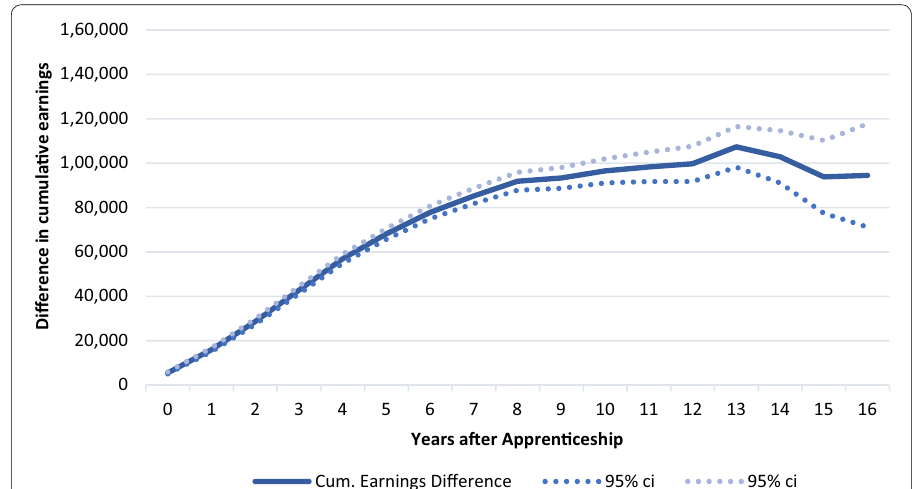
Fig. 10 Differences in cumulative earnings between matched foremen and academics with discount rate 5%